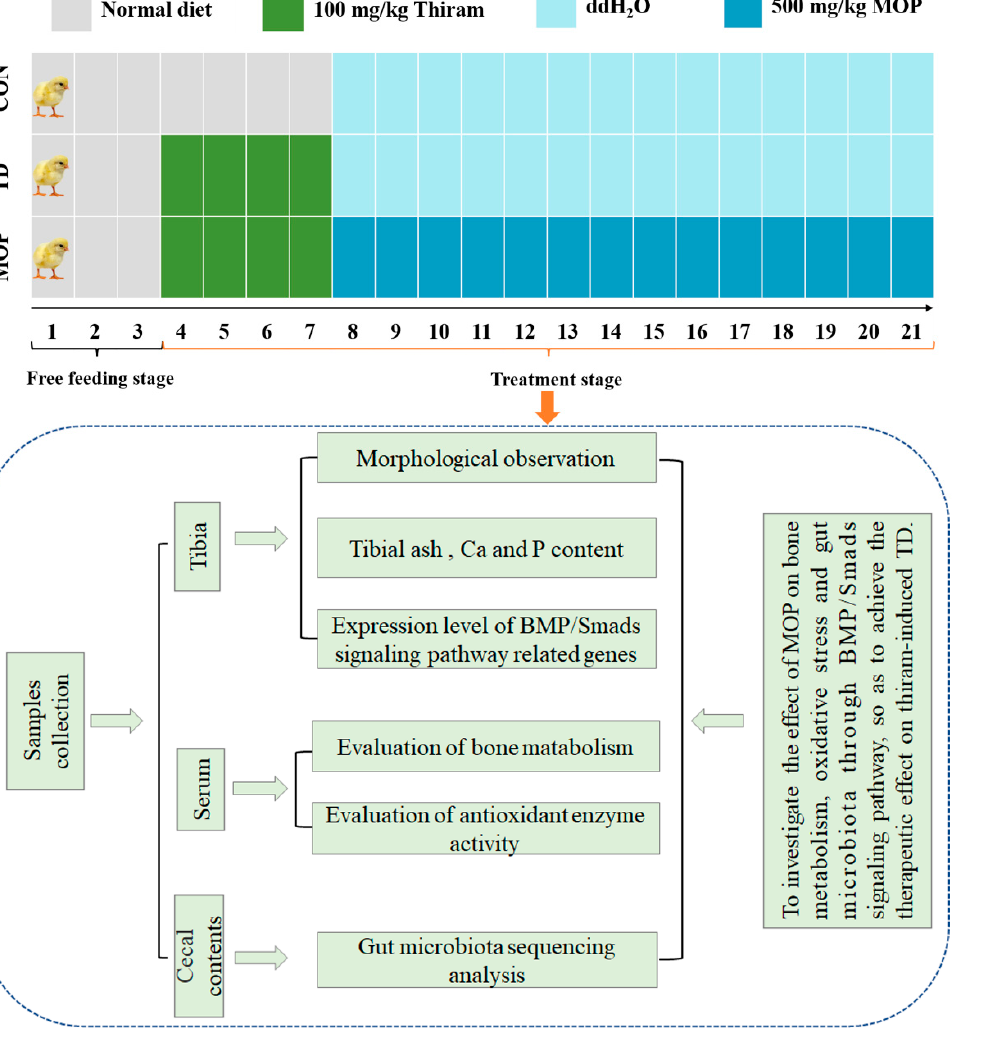
Figure 1. Experimental design diagram of MOP for treatment of thiram-induced tibial dyschondroplasia in broilers. ddH2O: double distilled water; MOP: Morinda officinalis polysaccharides.